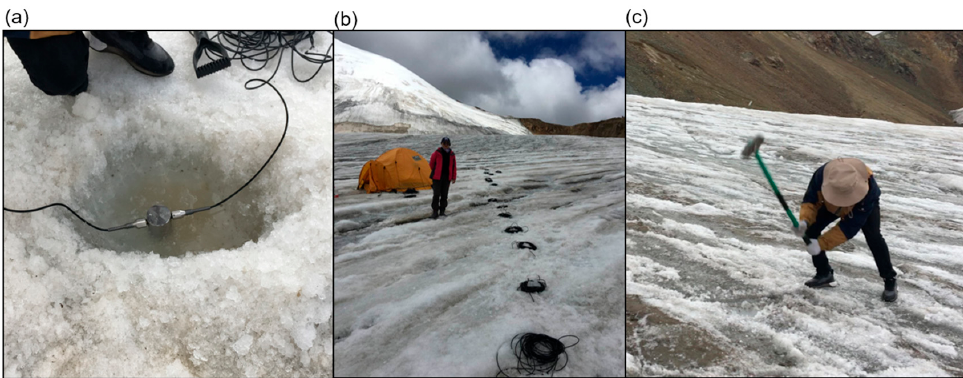
Figure 2. Field photos of seismic observations with the fiber optic seismometers on the KQGR Glacier. ( a ) A buried seismometer in the ice. ( b ) Installed seismic array. ( c ) Producing active seismic source by hitting the ice surface using a heavy hammer.